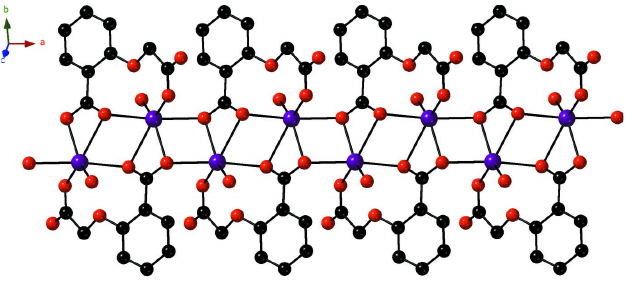
Figure 4 Inner [Cd(cmb)] n coordination polymer chain in the title compound,